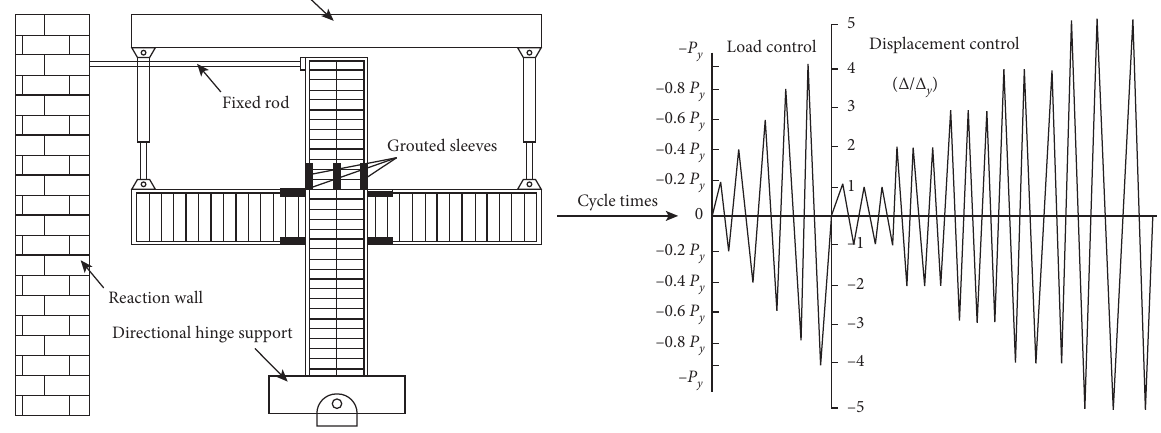
Figure 5: The loading device of test pieces. Table 6: The mechanical